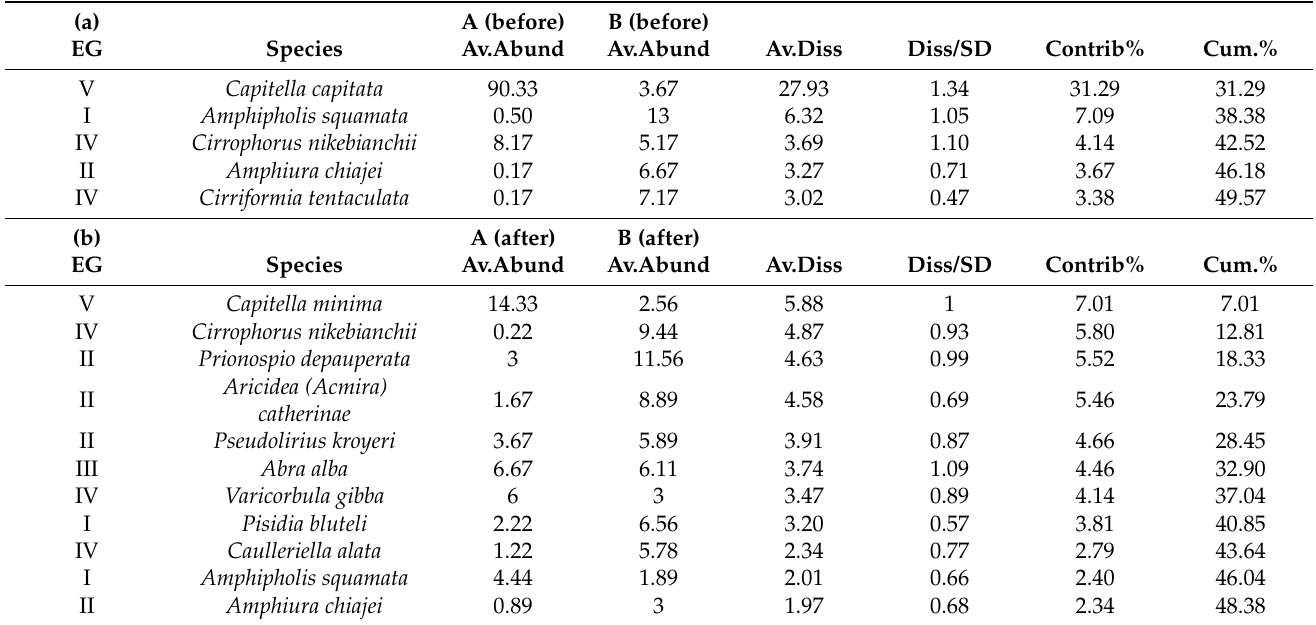
Table 9. List of discriminating species contributing more than 50% of the cumulative dissimilarity by SIMPER analysis, between the Treatment (A) and the Control (B) sites, before (a) and after (b) the conversion of the